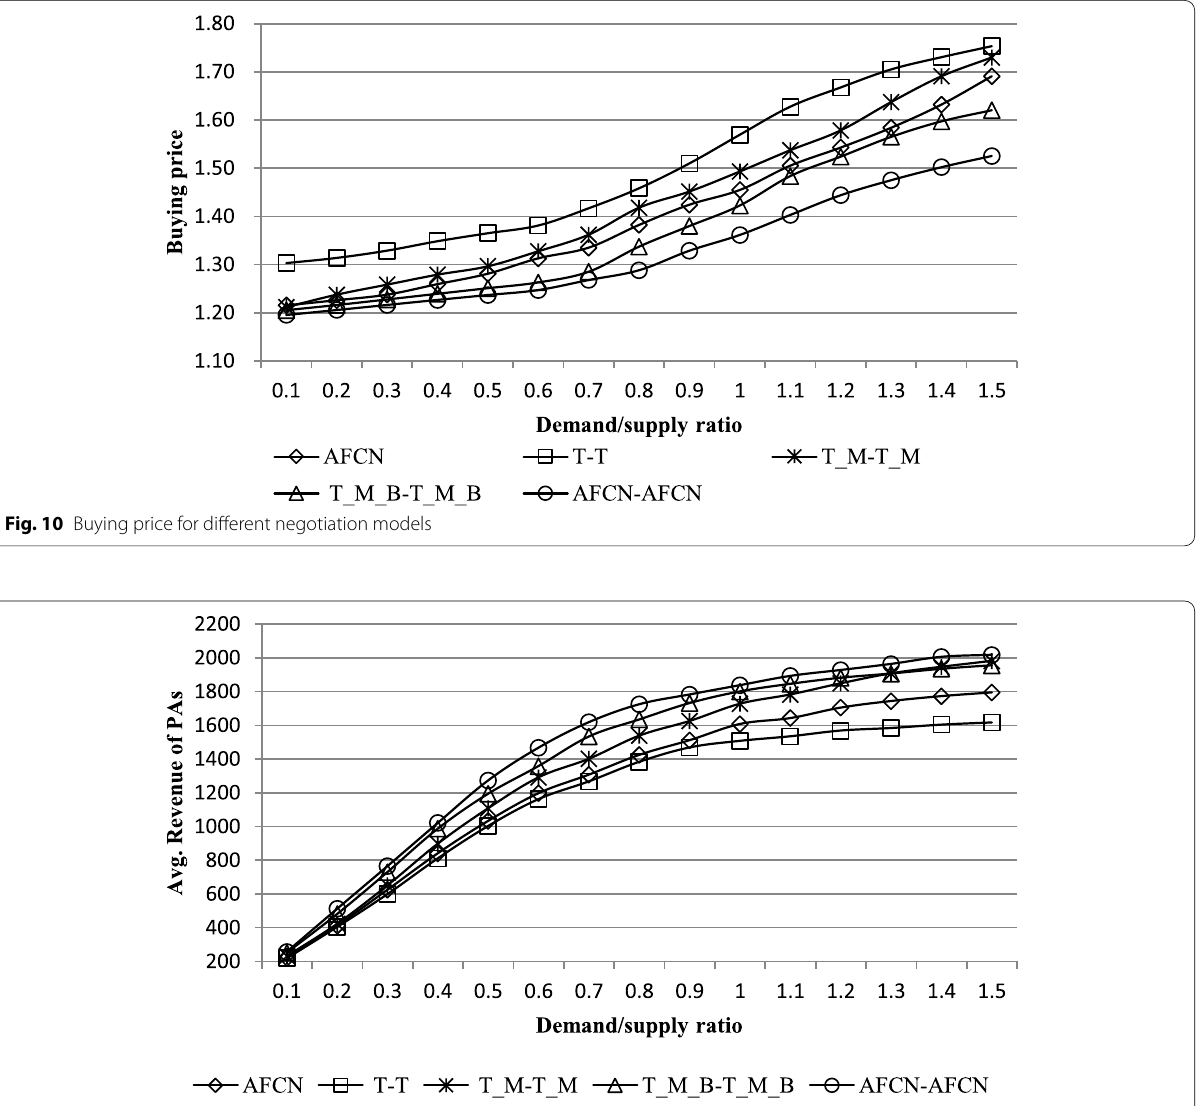
Fig. 11 Average revenue of PAs for different negotiation